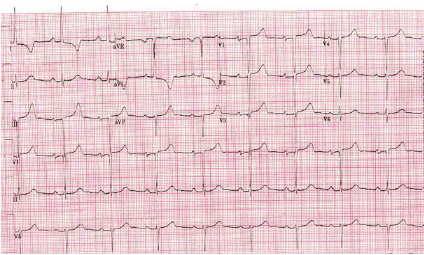
Figure 2: Two years prior to admission. QTc 500ms. Patient’s baseline ECG.